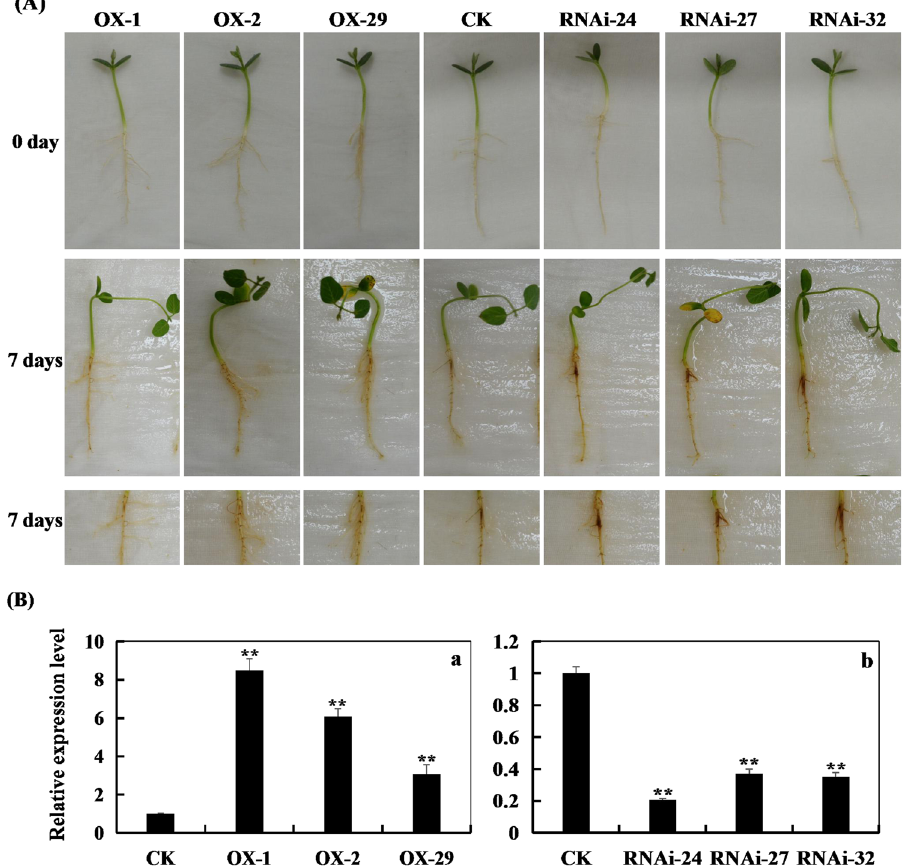
Figure 4. GmPAL2.1 enhances resistance to P . sojae in transgenic soybean roots. ( A ) Disease symptoms on the roots of the transgenic lines and non-transgenic lines treated with P . sojae at 7days. ( B ) qRT-PCR was used to determine the relative abundance of GmPAL2 . 1 in three GmPAL2 . 1 -overexpressing soybean plants (a) and three GmPAL2 . 1 -RNAi soybean plants (b) Non-transgenic soybean plants were used as controls. For each sample, three biological replicates were analyzed with their respective three technical replicates and statistically analyzed using Student’s t-test ( * P < 0.05, ** P < 0.01). Bars indicate the standard error of the